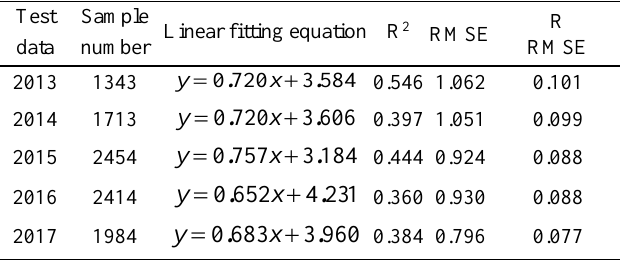
Table 1. Parameter of linear fitting cloud top height